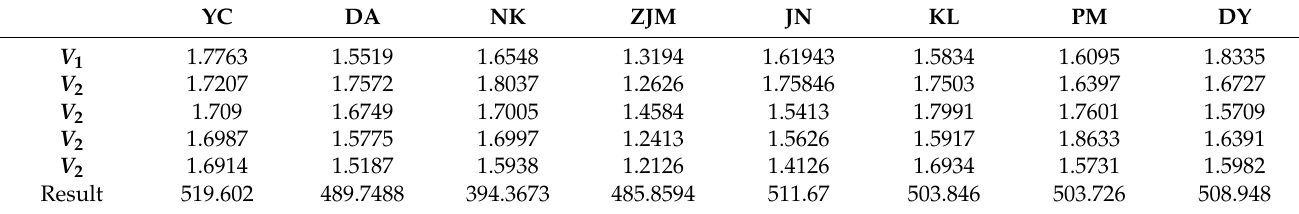
Table 8. The performance scores of eight coal-fired power